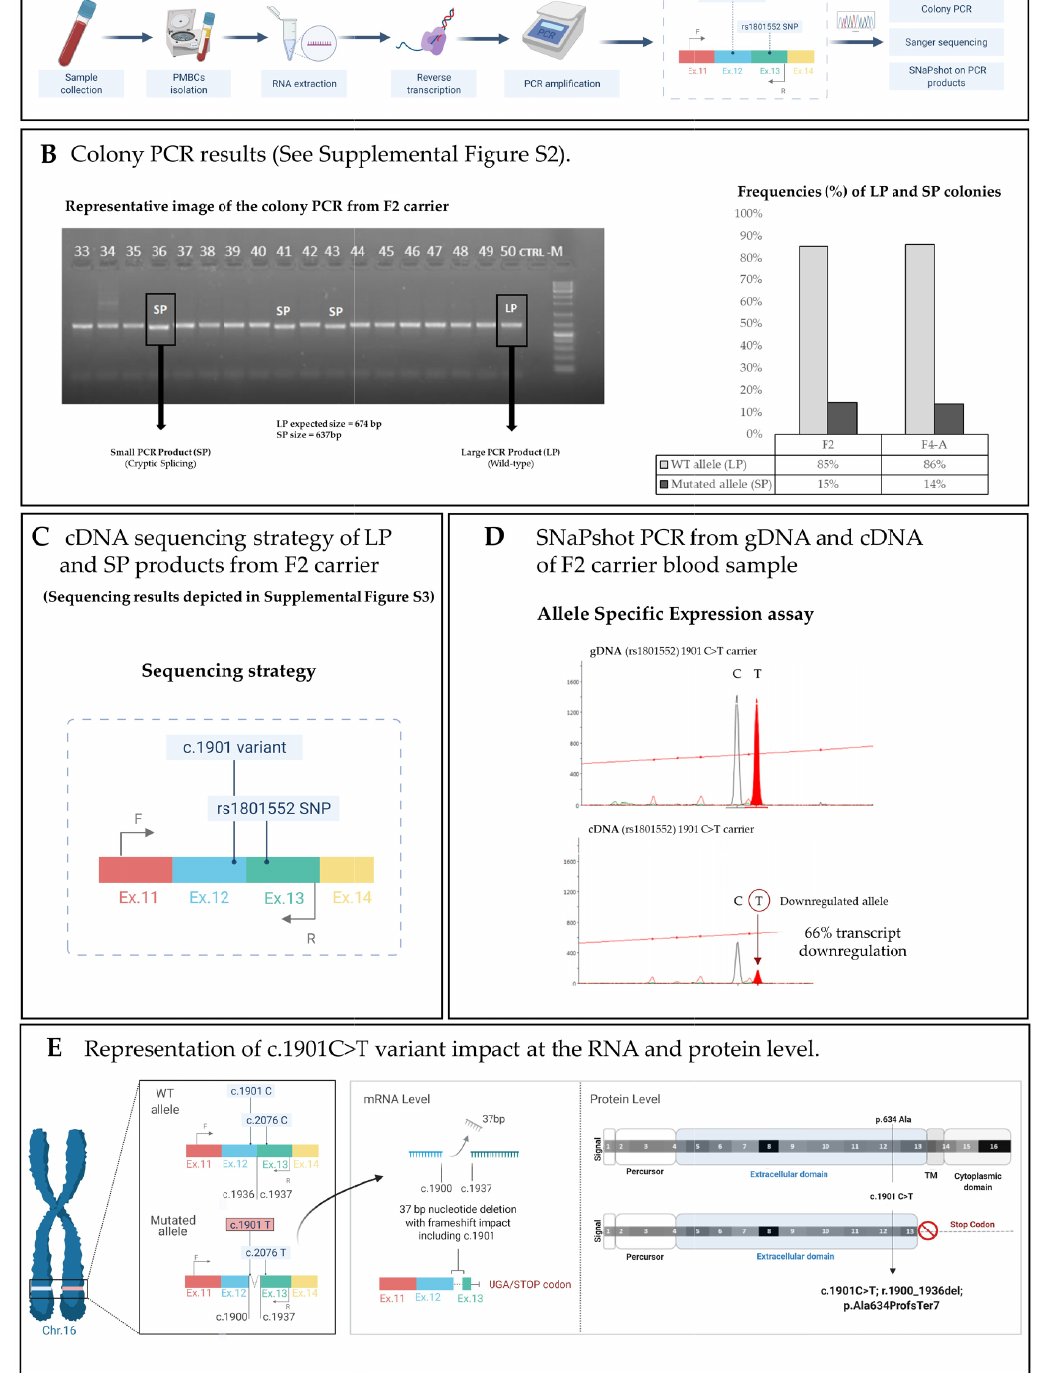
Figure 2. c.1901C>T CDH1 variant generates a cryptic splice site and a transcript with premature truncation. ( A ) Overview of the methodological strategy used for c.1901C>T transcript characterization; ( B ) Electrophoresis of the colony PCR after cloning cDNA of 2 carriers; ( C ) cDNA sequencing strategy of LP and SP products from F2 carrier; ( D ) SNaPshot PCR from gDNA and cDNA of F2 carrier blood sample; ( E ) representation of c.1901C>T impact at the RNA and protein level. PMBCs, peripheral blood mononuclear cells; gDNA, genomic DNA; cDNA, complementary DNA; WT, wild